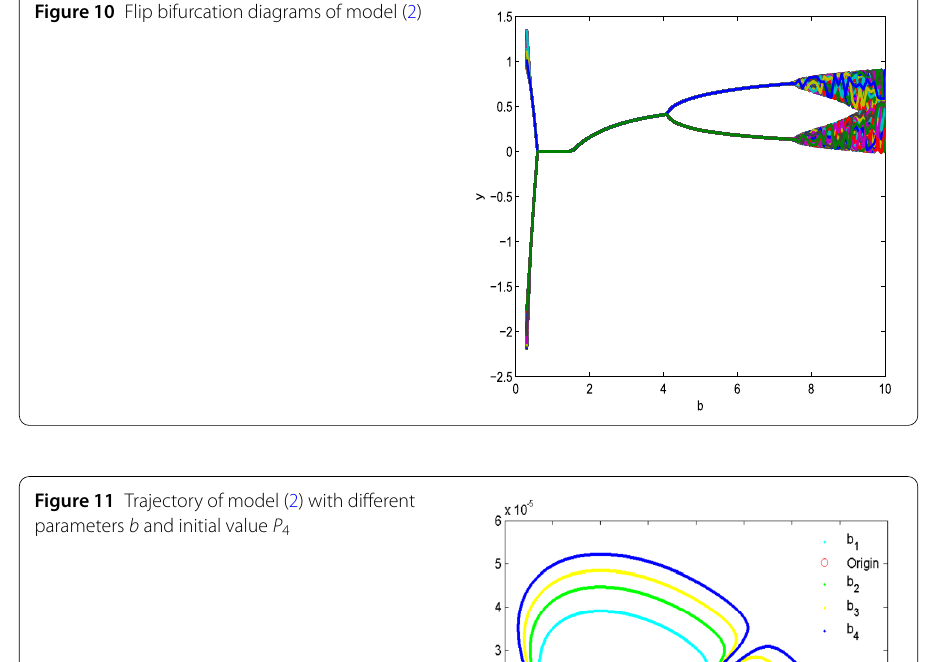
Figure 10 Flip bifurcation diagrams of model (2)